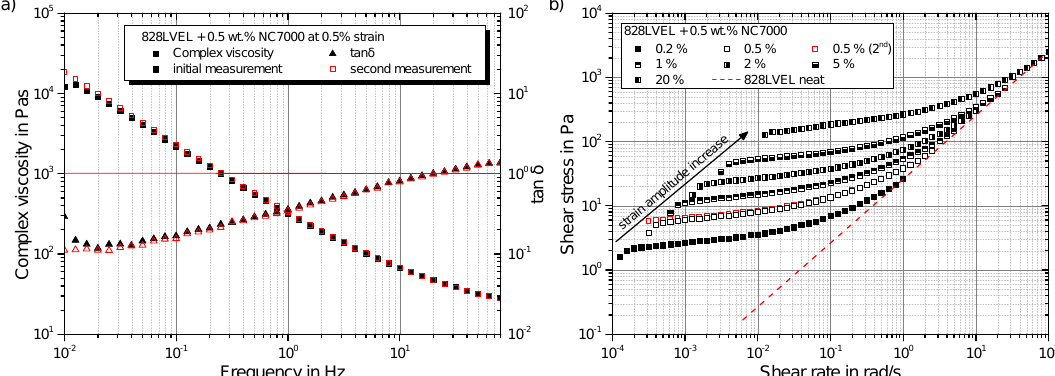
Figure 11. Dependency of ( a ) complex viscosity on frequency and ( b ) shear stress on shear